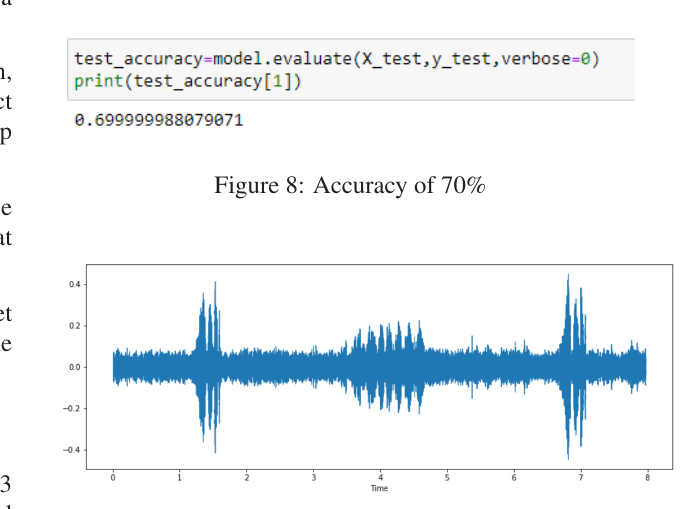
Figure 9: Audio waveform of Alder Flycatcher